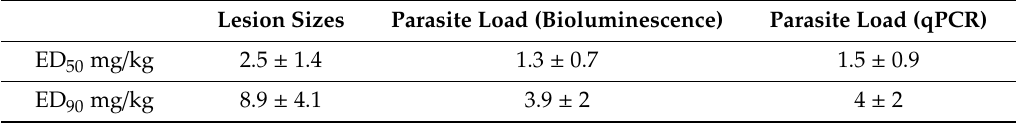
Table 5. ED50 and ED90 of AmB-CH-TPP in BALB / c mice infected with L. major